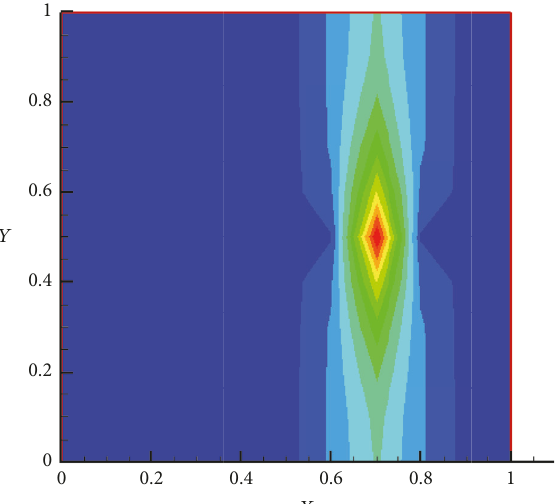
Figure 6: Energy density distribution predicted by EFEA while the plate is excited at point 𝑏 .